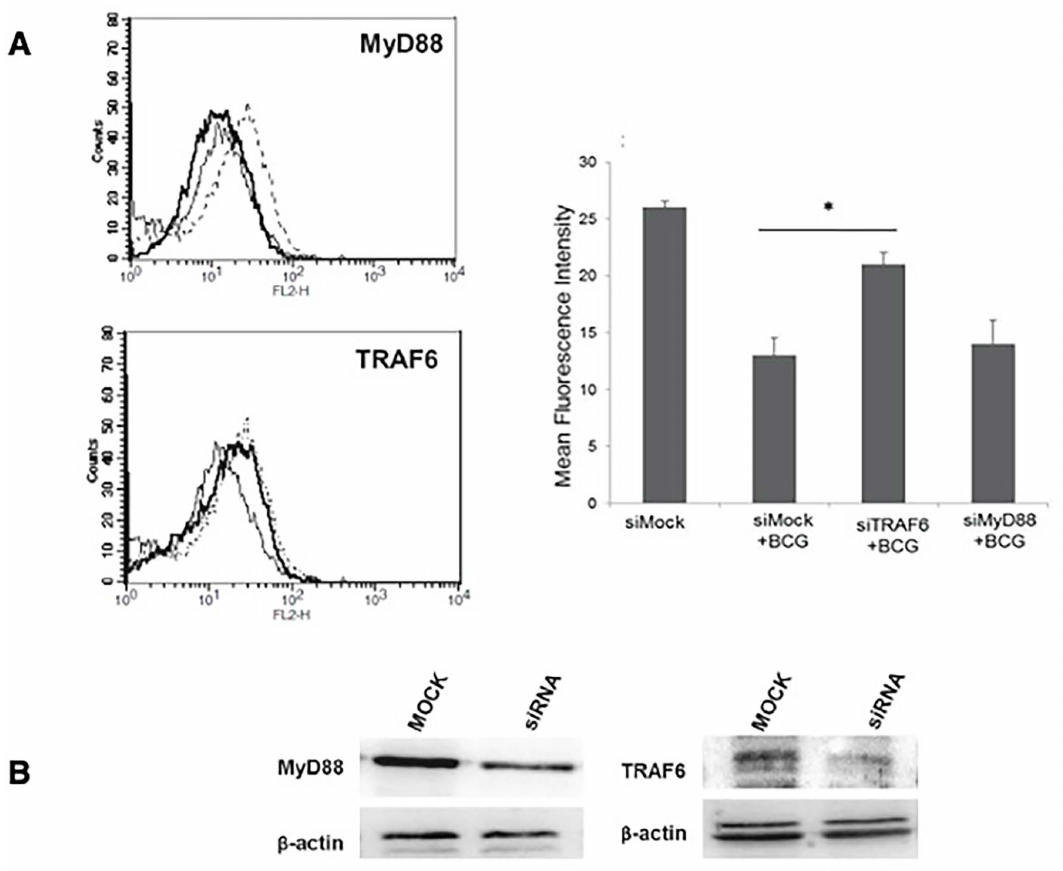
Figure 5: TLR pathway regulates BCG mediated IFN-γR expression on macrophages. (A) THP-1 derived macrophages were transfected with specific siRNAs against indicated molecules for 36h followed by infection with M. bovis BCG for 24h. IFN-γR levels were monitored by flow cytometry. In all the panels, *p<0.05 and **p<0.01, using one-way ANOVA with Tukey’s correction to calculate statistical significance between different groups. Data are represented as mean fluorescence intensities and expressed as mean ± S.D. (n=3). Dotted lines represent receptor levels in groups transfected with control siRNAs (MOCK), thin lines represent receptor levels in M. bovis BCG infected groups transfected with control siRNAs and bold black lines represent receptor levels in M. bovis BCG infected groups transfected with specific siRNAs against indicated molecules. (B) Western blots to depict the knockdown efficiency of the siRNA treatment for the indicated